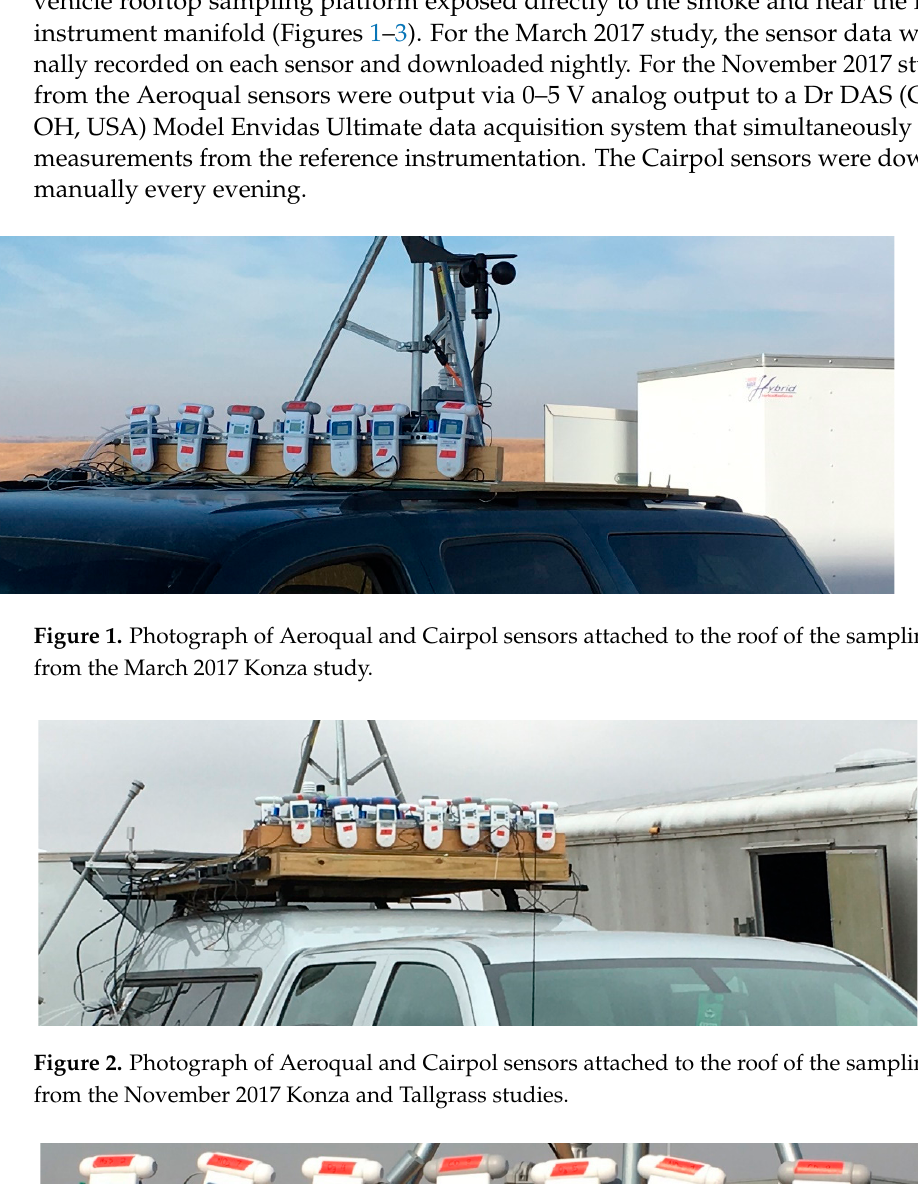
Table 2. Meteorological parameters for Fall 2017 study days (averaged over daily measurement period).